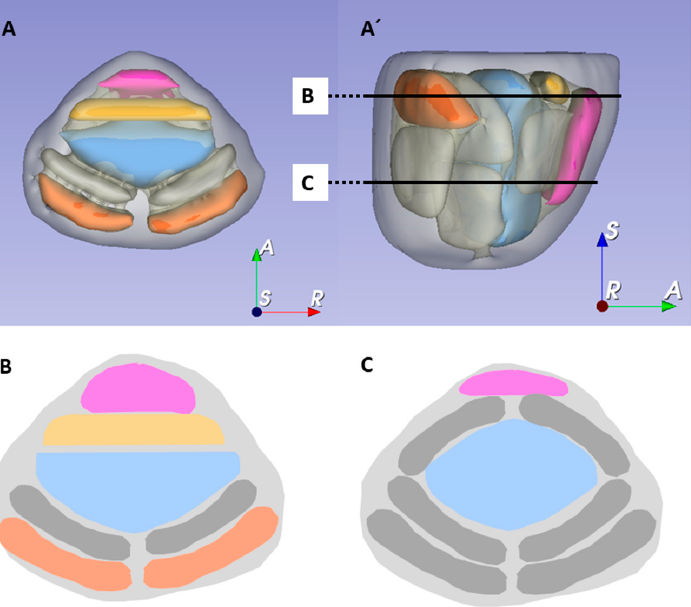
Figure 1. 3D visualization of the Ginsburg scheme in different angles ( A , A (cid:48) ). ( B ) and ( C ) show axial planes in two different levels. Inherent blind sectors are marked in colors: anterior region (pink), central transition zone (blue), basoventral sector (yellow), basodorsal sector (orange). The grey-colored sectors illustrate the original Ginsburg